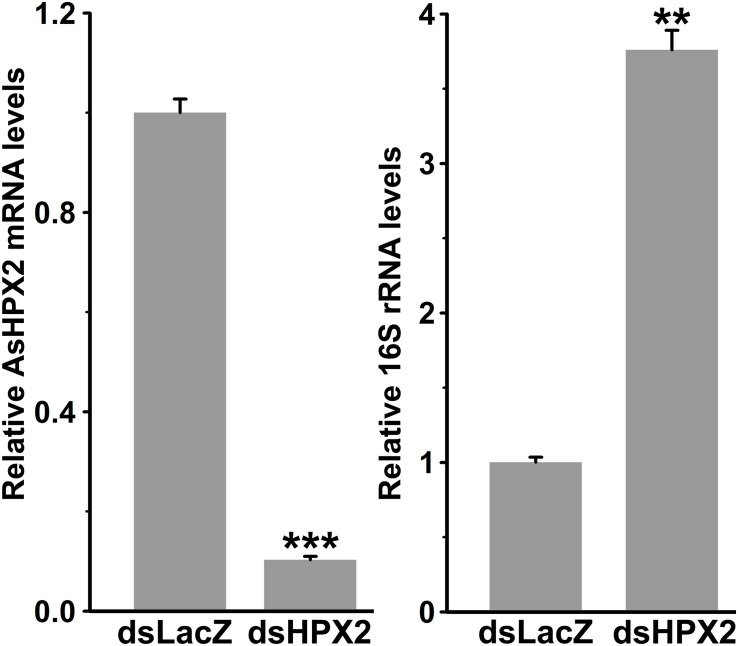
Relative levels of 16S rRNA in AsHPX2 silenced midguts. Mosquitoes were injected with dsLacZ (controls) or dsAsHPX2 (silenced) RNA and relative levels of AsHPX2 mRNA or 16S rRNA were analyzed in their midguts 4 days post-injection. Significant differences (p < 0.001 or 0.01) are shown by three or two asterisks, respectively.